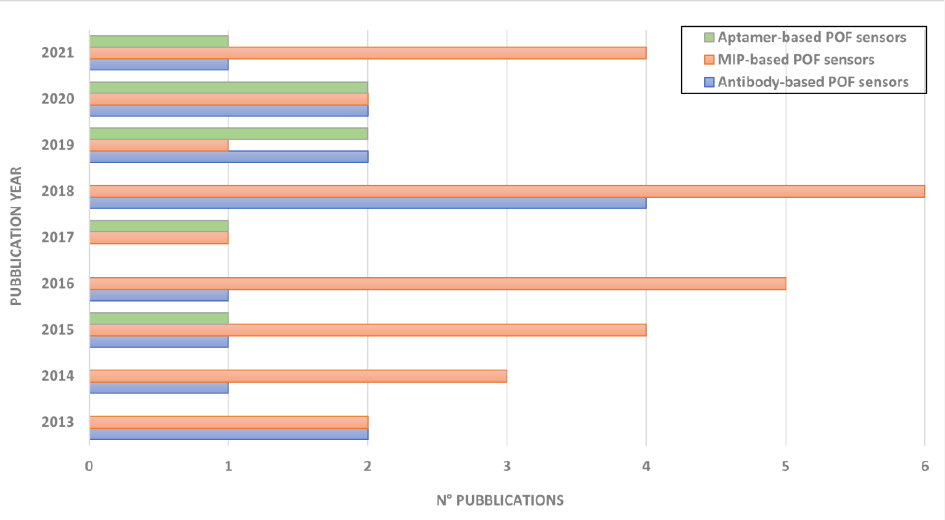
Figure 2. Comparison of antibody-, MIP-, or aptamer-based POF sensors during years (The number of items were obtained from Web of Knowledge website for searching specific keywords; aptamer or MIP or antibodies and plastic optical fiber).